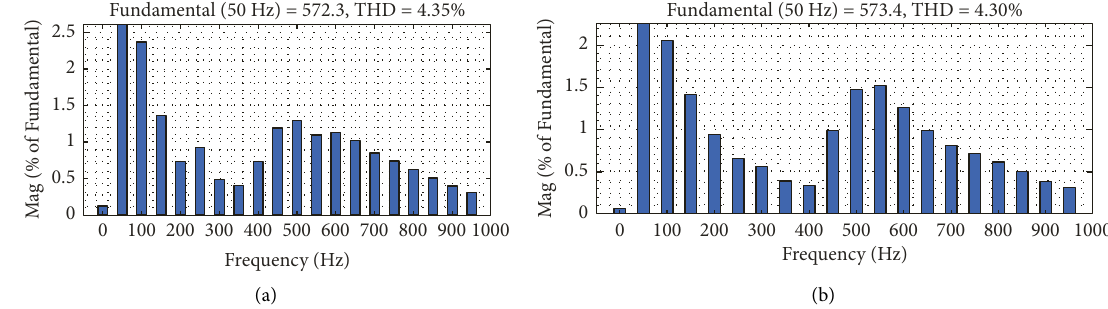
Figure 18: THD for output voltage. (a) Using PO. (b) Using the